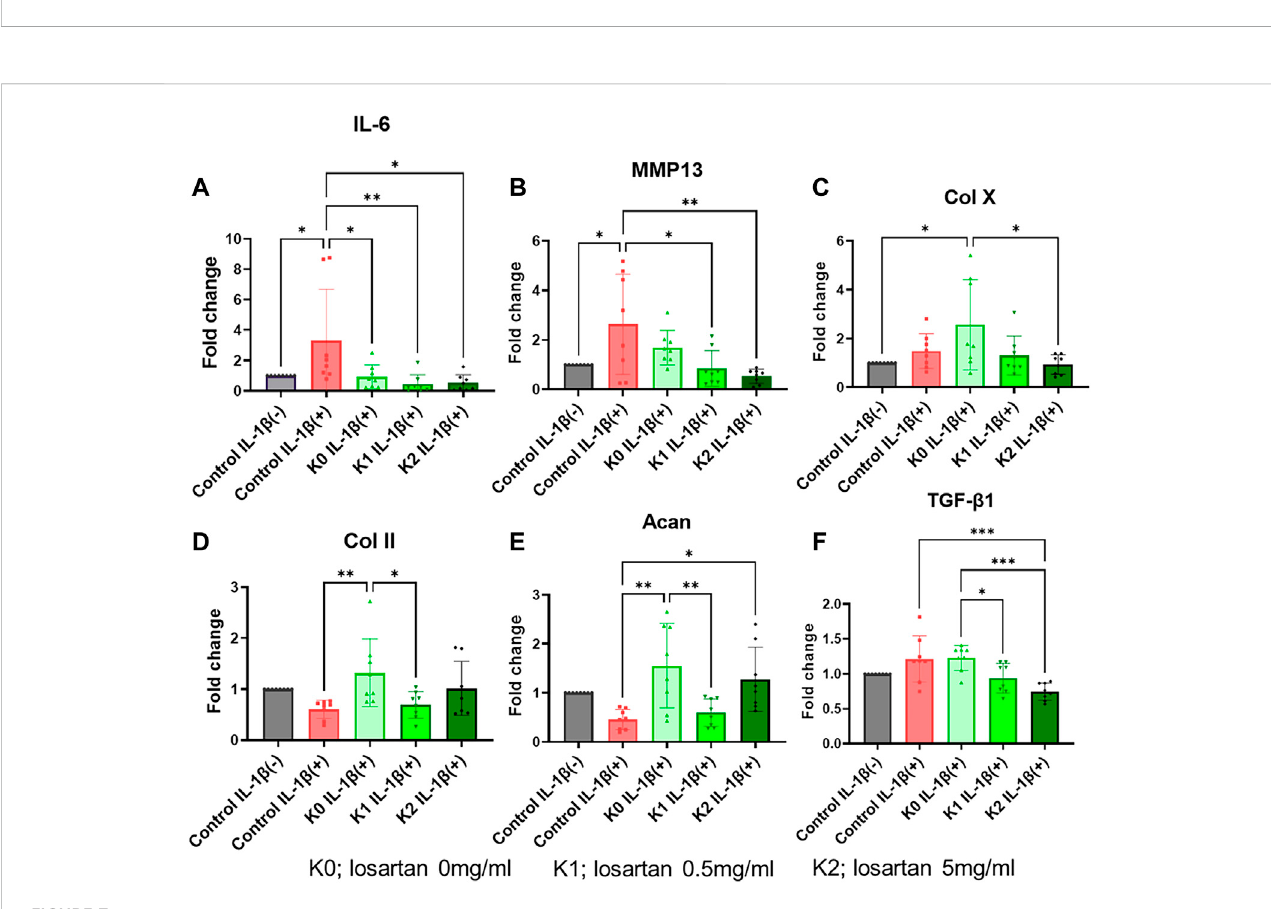
Positively charged nano fi bers have pro-regenerative impact on OA-induced chondrocytes. Relative expression of (A) interleukin-6 , (B) mmp13 , (C) collagen X , (D) collagen II , and (E) tgf- β 1 in chondrocytes following treatment with IL-1 β (red bar) or with varying doses of losartan encapsulated in positively charged K nano fi bers (green bars) compared to untreated controls (grey bar). K0; losartan 0 mg/ml, K1; losartan 0.5 mg/dL, and K2; losartan 5 mg/dL *; p < 0.05, **; p < 0.01, and ***; p < 0.001. N = 8 per each